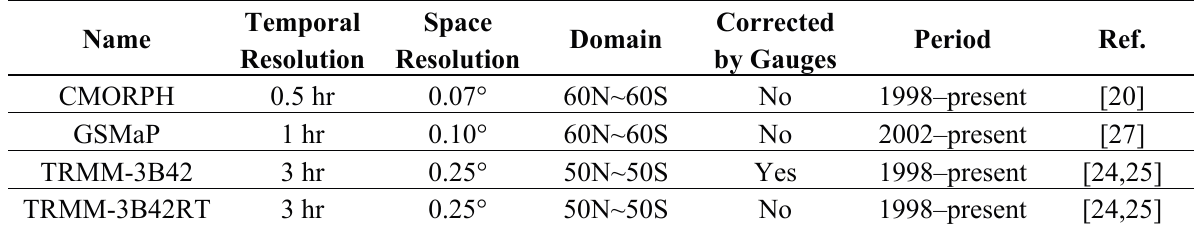
Table 1. Summary of four satellite precipitation estimates. Four satellite